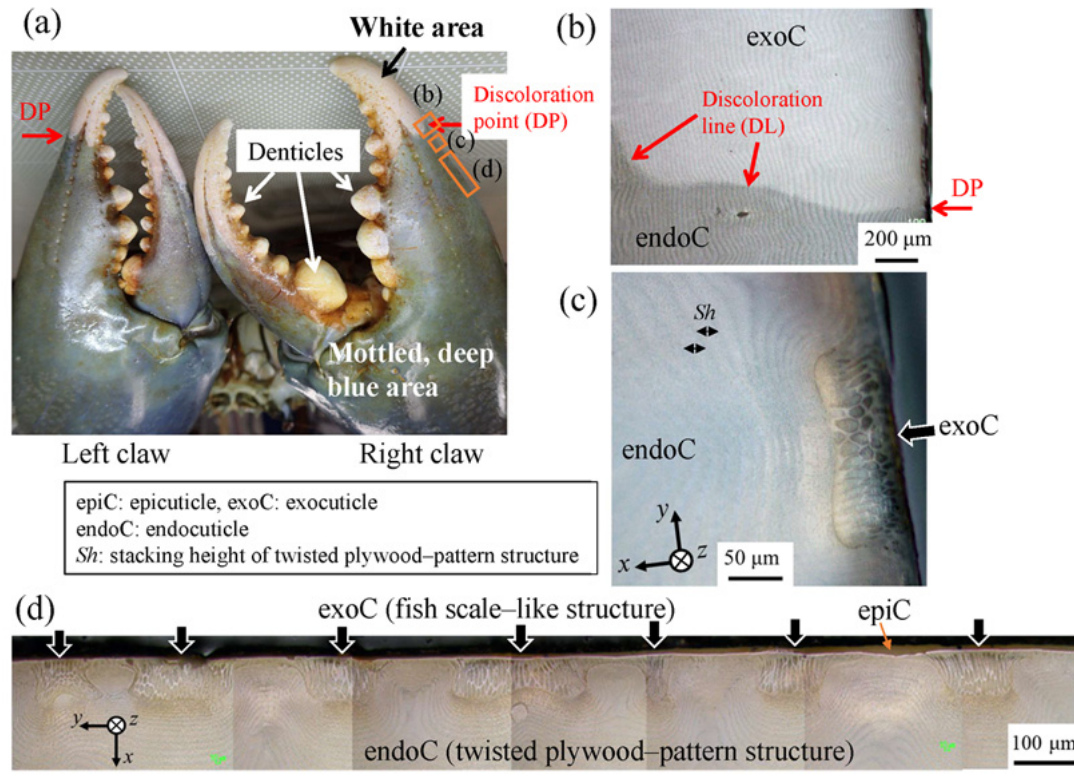
Figure 1. ( a ) Claws of a mud crab and optical micrographs (OMs) of a cross section of ( b ) the white area and ( c , d ) the mottled, deep-blue area. Here, ( d ) shows the wide range on the mottled, deep-blue surface, and arrows indicate exocuticles that are irregularly present on the surface.